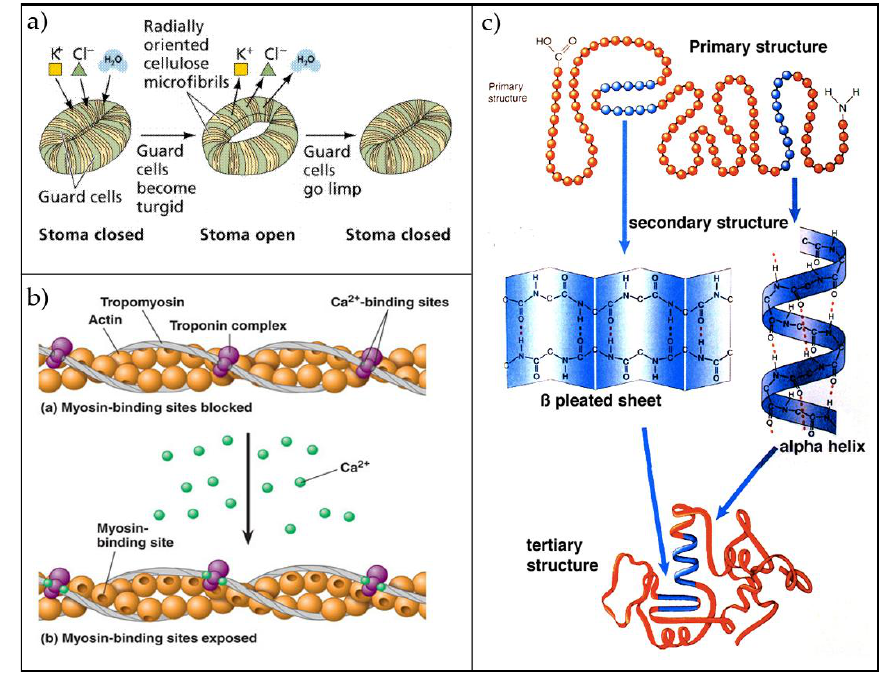
Figure 4. Inspiring biological systems, ( a ) guard cells, ( b ) troponin and tropomyosin, ( c ) silk–protein (Adapted from: ( a ) [58], ( b ) [54], ( c )